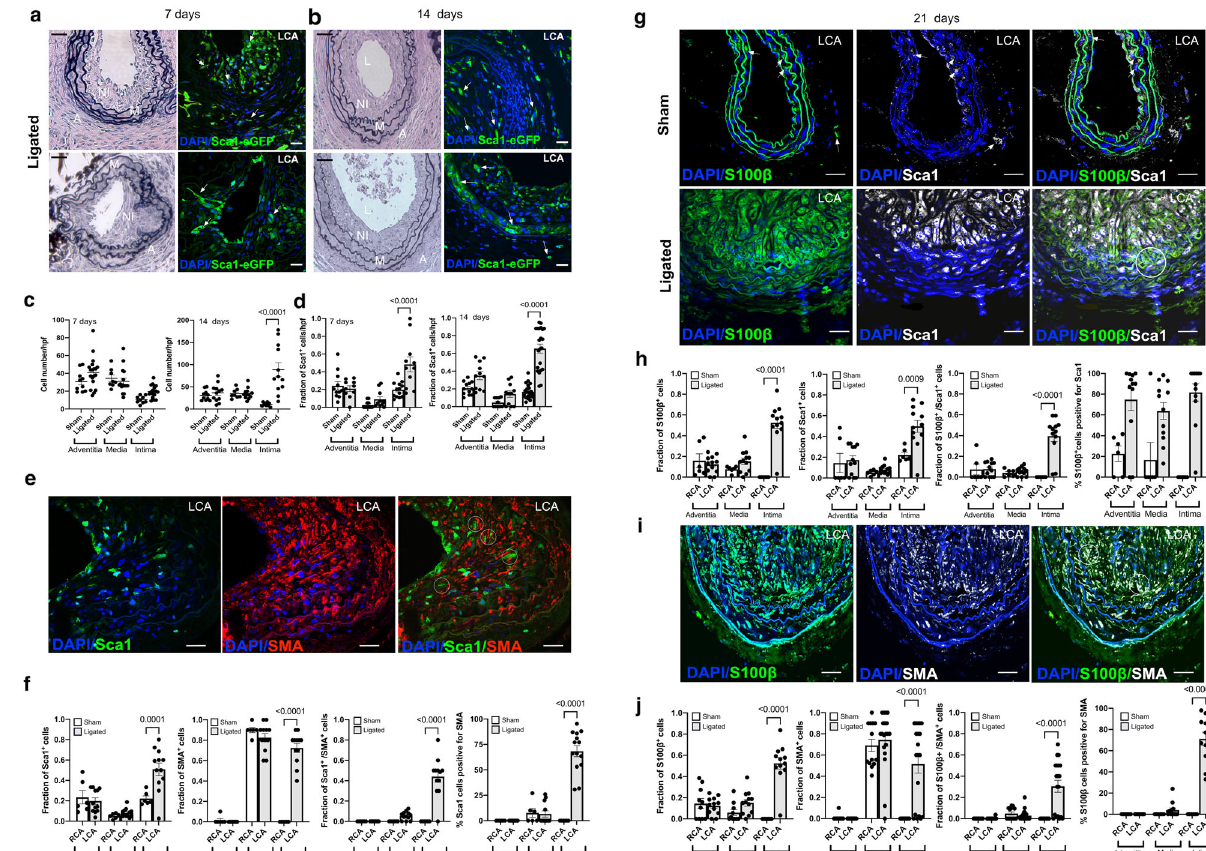
Fig. 2 Expression of Sca1-eGFP and S100 β -eGFP cells following iatrogenic fl ow restriction after 7, 14, and 21 days. a, b Representative Verhoeff-Van Gieson stained sections and corresponding confocal fl uorescence images of DAPI nuclei (blue) and Sca1-eGFP (green) expression in LCA after a 7 days and b 14 days. Scale bar = 20 µm. c The number of DAPI nuclei/hpf in cross sections of adventitia, media and intima following partial ligation of the LCA after 7 and 14 days compared to sham controls. Data are the mean ± SEM of 3 – 5 representative images per animal, n = 4. d The fraction of Sca1 cells/high power fi eld (hpf) in the adventitia, media, and intima of sham and ligated vessels after 7 days and 14 days. Data are the mean ± SEM of 10 – 15 sections from four animals per experimental group. e Representative confocal fl uorescence images of DAPI nuclei (blue), immuno fl uorescence of anti-eGFP (green) expression and anti-SMA (Red) in the LCA 14 days post- ligation in Sca1-eGFP mice. Data are representative of fi ve images per animal. f Cumulative analysis of Sca1 + cells, SMA + cells, double stained Sca1/SMA-positive cells and the percentage of Sca1 + cells that were SMA1 + in the adventitial, medial and intimal layer of RCA and LCA vessels after 21 days, respectively. Data are the mean ± SEM, n = 15 – 20 sections from 5 animals. g Representative confocal fl uorescence images of DAPI nuclei (blue), immuno fl uorescence of anti-eGFP (green) expression and anti-Sca1 (far red white) in sham and ligated LCA after 21 days in S100 β -eGFP mice. Scale bar = 20 µm. h Cumulative analysis of S100 β + cells, Sca1 + cells, double stained Sca1/S100 β positive cells and the percentage of S100 β + cells that were Sca1 + in the adventitial, medial and intimal layer of RCA and LCA vessels, respectively after 21 days in S100 β -eGFP mice. Data are the mean ± SEM, n = 15 – 20 sections from 5 animals/group. i . Representative confocal fl uorescence images of DAPI nuclei (blue), immuno fl uorescence of anti-eGFP (green) expression and anti-SMA (far red, white) in the RCA and LCA 21 days post-ligation in S100 β -eGFP mice. Data are from a minimum of four animals per experimental group. Scale bar = 20µm. j Cumulative analysis of S100 β + cells, SMA + cells, double stained S100 β /SMA-positive cells and the percentage of S100 β + cells that were SMA + in the adventitial, medial and intimal layer of RCA and LCA vessels, respectively, after 21 days in S100 β -eGFP mice. Data are the mean ± SEM, n = 15 – 20 sections from 4